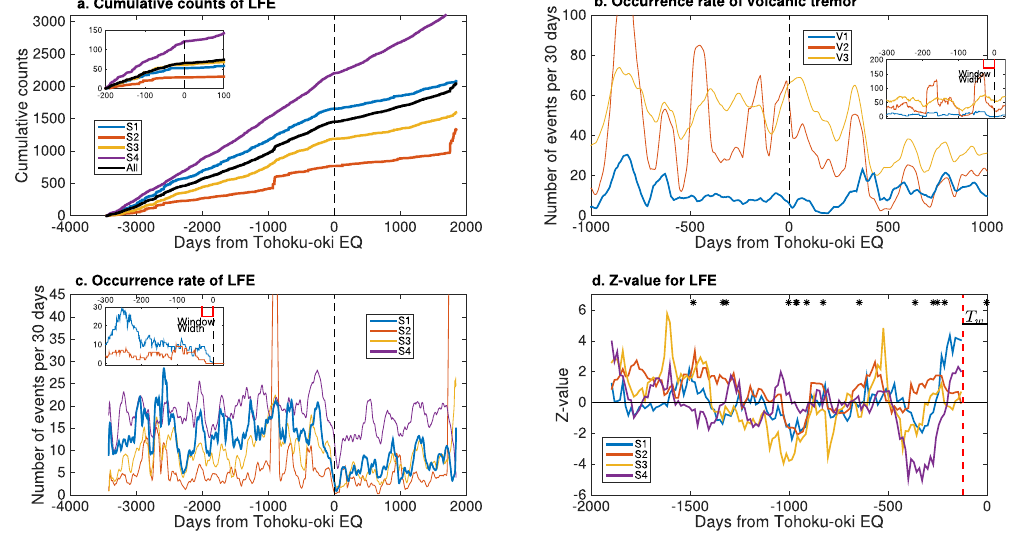
Figure 5. Processed data regarding the occurrence of neighboring events. Panel a: Evolution of cumulative LFEs for classes S1, S2, S3 and S4. The black curve denotes cumulative events for all classes divided by four. Note that the bursting behavior of S2 is observed in the period between − 950 and − 900 days and in the period between 1750 and 1850 days. In these periods, more than 95% of epicenters of S2 are localized in the rectangular area between latitudes 43.34°N–43.44°N and longitudes 143.95°E–144.05°E close to the Meakandake volcano. Panel b: Evolution of volcanic tremors for classes V1, V2 and V3. The number of volcanic tremor is evaluated in the same manner as in Panel c. Panel c: Evolution of LFEs for classes S1, S2, S3 and S4. The number of LFEs denoted by n ( z ) is evaluated with the width of window set 30 days backward: i 1 where  ⋅ ( ) is an indicator function; ′ = − t with t tohoku being the origin time of the Tohoku-oki EQ; z is tohoku an integer ranging from − 3448 to 1847. For the main graph, n ( z ) is further smoothed using a moving average of a 90 day-window (45 days backward, 45 days forward) while it is not smoothed in the inset where occurrence rates for classes S1 and S2 are displayed. Panel d: Z-values for each class of LFE. We set the width of window ( T w ) to 120 days and the moving step to 14 days. The initial time ( t 0 ) is Jan. 1, 2006, while the terminal time ( t e ) is March 8, 2011. We did not consider spatial differences, but instead we used all LFE data for each class. On the top of the panel, the occurrence of large earthquakes with magnitude larger than 6 is denoted by black